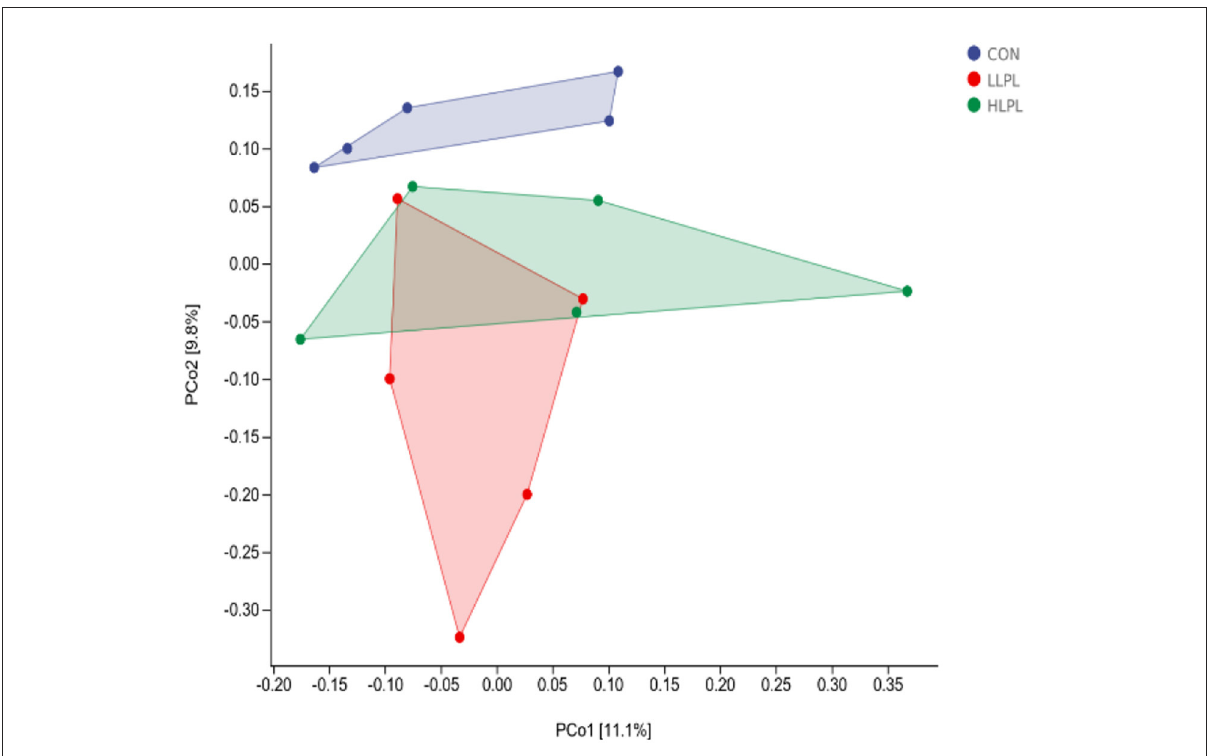
FIGURE1 Principal coordinate analysis (PCoA) of the fecal microbial communities based on unweighted UniFrac. CON, control; LLPL, 0.5 g/kg lysophospholipids; HLPL, 0.75 g/kg